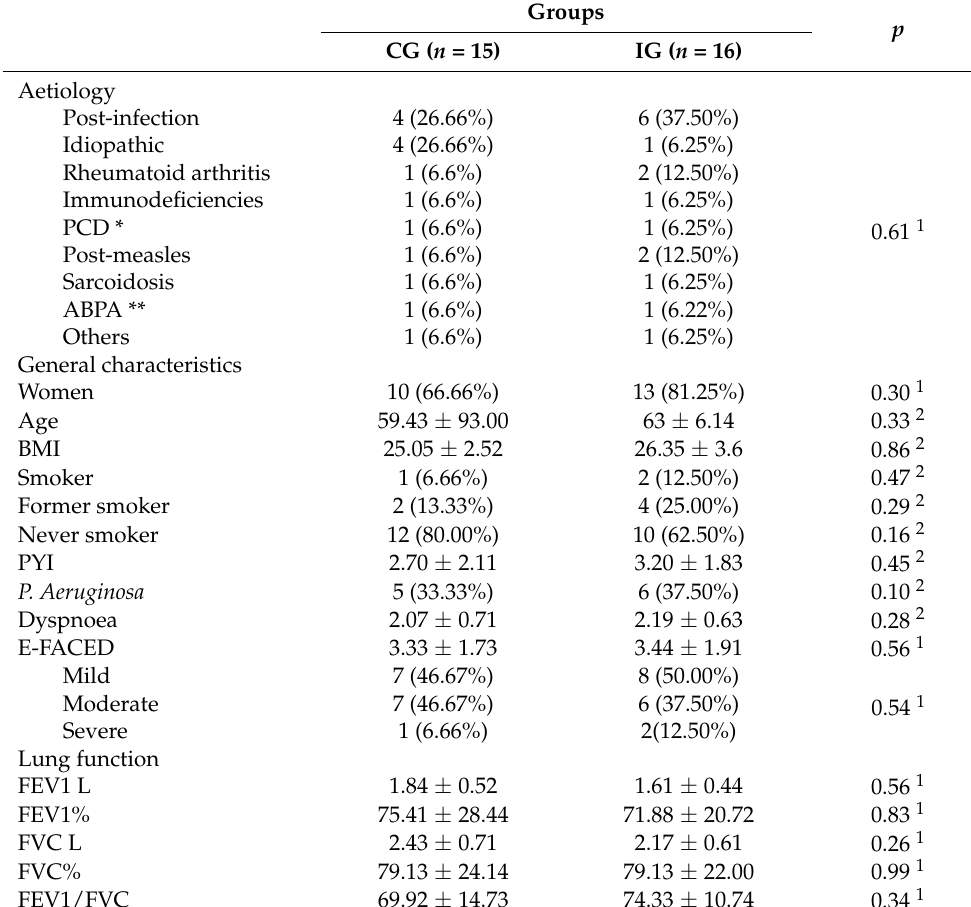
Table 1. Characteristics of the